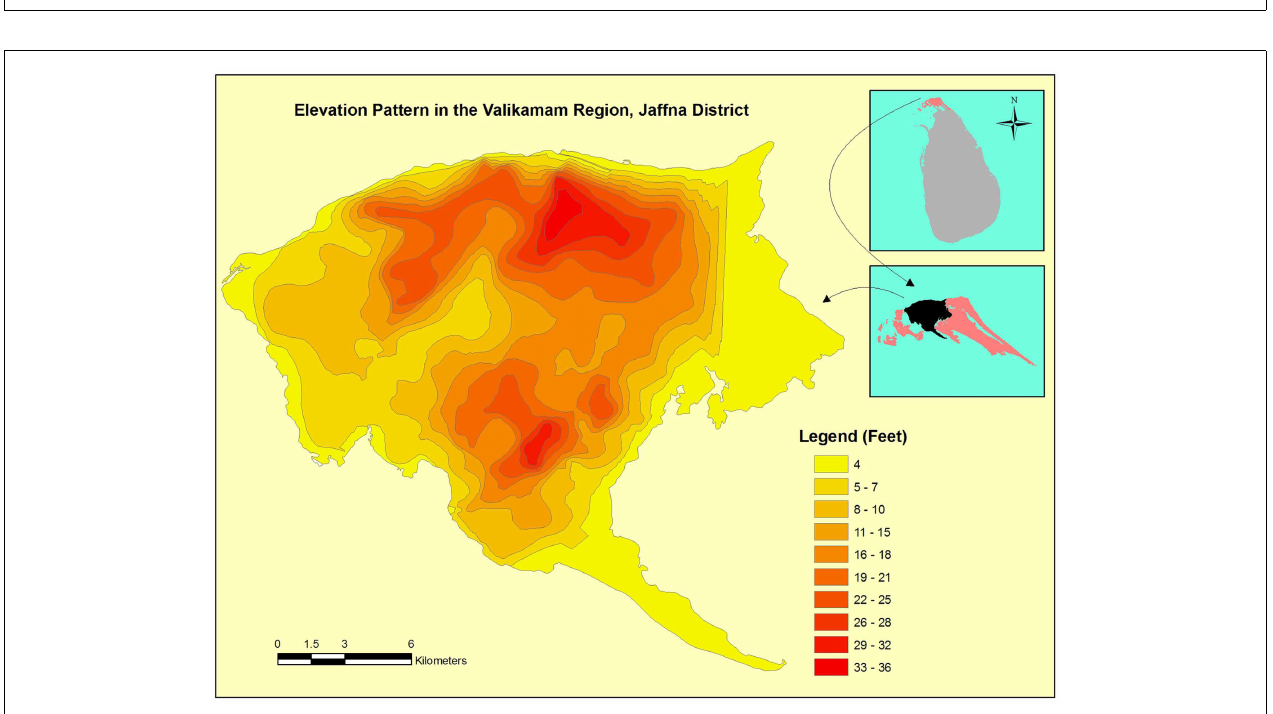
FIGURE 6 | Map of the different administrative divisions in the Jaffna peninsula.